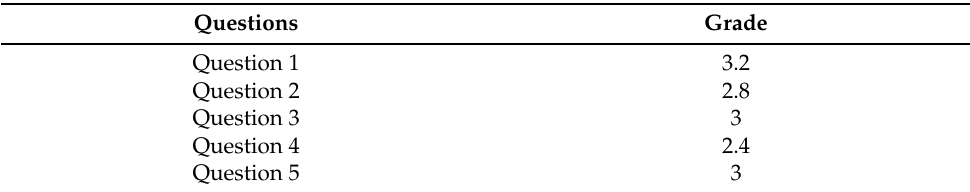
Table 13. Means of the results obtained in the evaluation using the questionnaire for multi-instance classification of Corel-300 dataset.